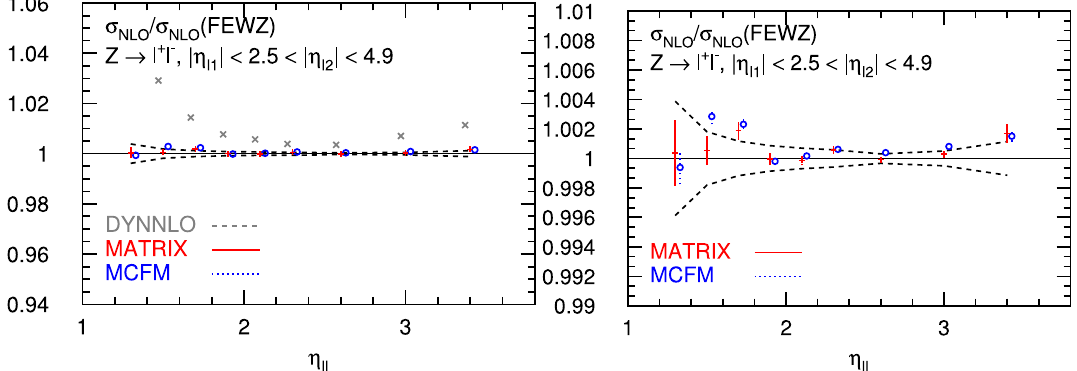
| ≤ 2 . 5 and 2 . 5 ≤ | η | ≤ 4 . 9. Predictions by DYNNLO , MATRIX l 2 1